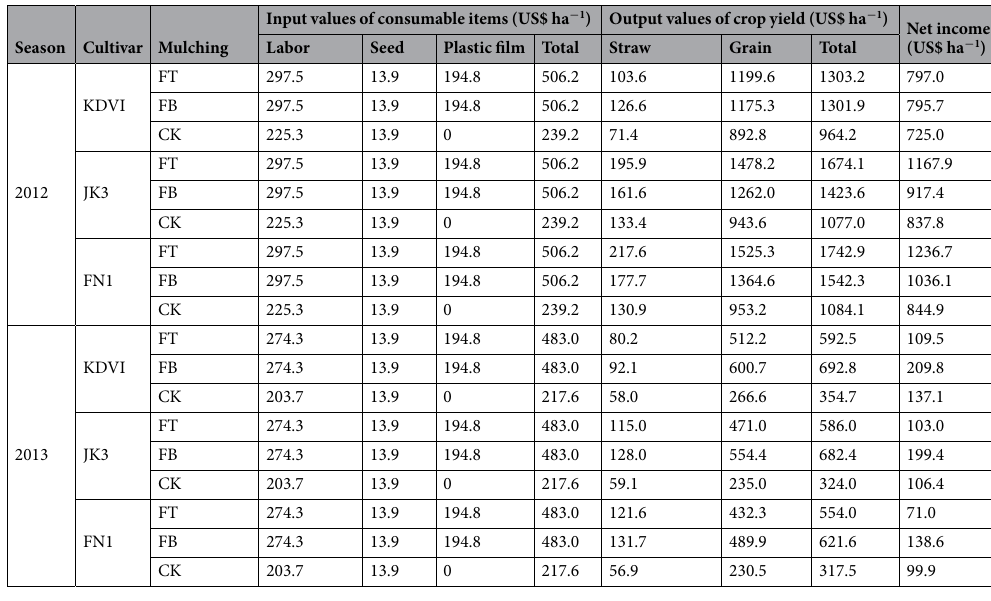
Table 4. Economic benefits as affected by maize cultivars (early- mid- and late-maturing, KDVI, JK3 and FN1, respectively) and ridge-furrow differingin mulching materials (FT, alternative ridge-furrow with transparent film mulching; FB, alternative ridge-furrow with black film mulching and CK, alternative ridge-furrow with no mulching) in both growing seasons, on a sandy clay loam in Kenya, east African Plateau. Price per unit